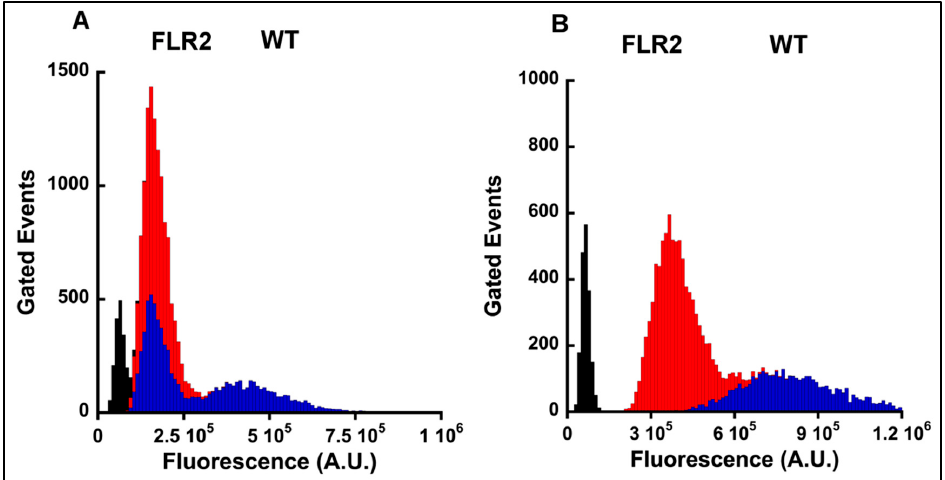
Figure 4. Lower expression levels of α 2 and β 1 integrins are observed in FLR2 Panc ‐ 1 cells than in WT Panc ‐ 1 cells. Expression levels of α 2 ( A ) and β 1 integrins ( B ) in FLR2 and WT Panc ‐ 1 cells were determined by flow cytometry. Staining for α 2 or β 1 integrin in WT Panc ‐ 1 cells is shown as blue histograms, and in FLR2 Panc ‐ 1 cells as red histograms. Staining of cells with the secondary antibody only is indicated by the black histogram in each figure. The experiments were performed three independent times. Representative histograms are